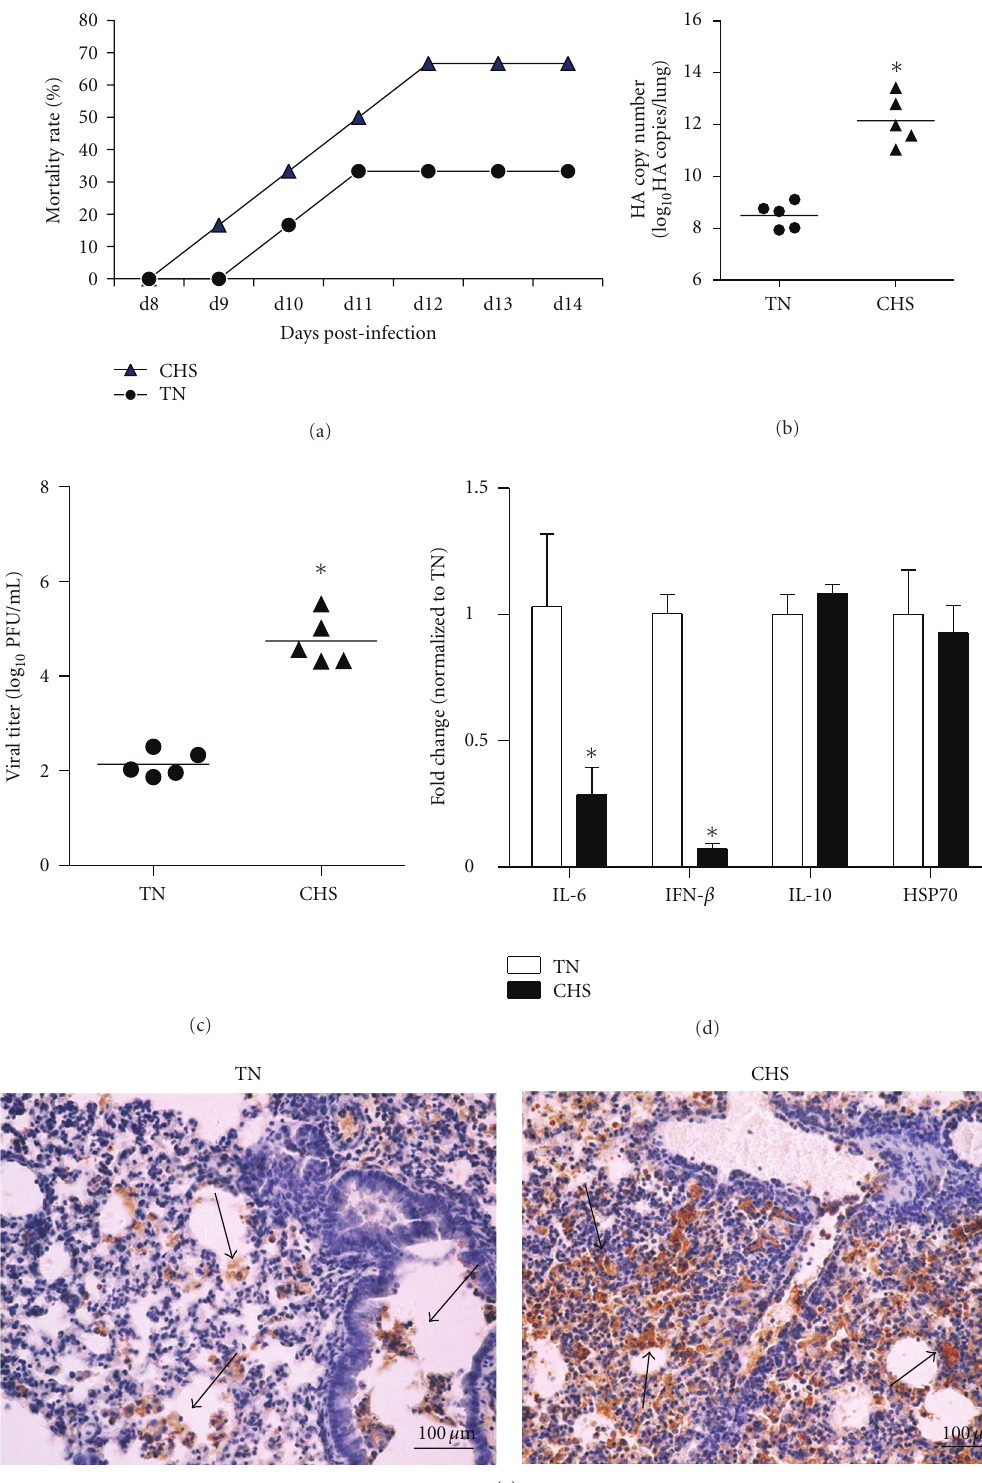
Figure 3: E ff ects of CHS on the virulence of HPAIV in the infected mice. (a) Six mice per group were observed for mortality at 14 days. And the viral load in lungs at day 3 postinfection was determined by real-time PCR (b) and plaque assay (c). (d) The mRNA levels of IL-6, IFN- β , IL-10, and HSP70 in the lung at day 3 postinfection were determined by qPCR. ∗ indicates P < . 05 when compared with the TN group. (e) Representative lung sections from each group were stained with immunohistochemical staining with an antiinfluenza NP mAb (400 × ), and the arrow indicated the NP positive